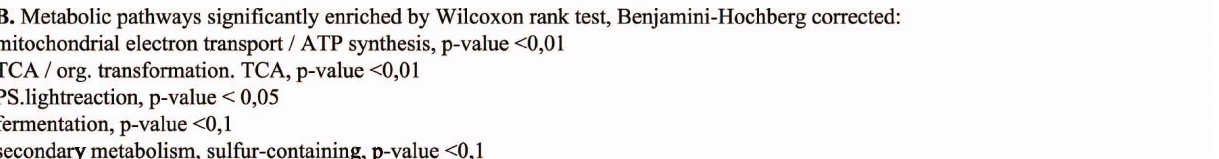
Figure 8. MAPMAN metabolic overview of transcriptional changes at day7. Shown are the overall gene expression changes related to the metabolism day7 between 3MB treated leaves 2 and controls. The Wilcoxon rank sum, with Benjamini-Hochberg correction, is shown below.